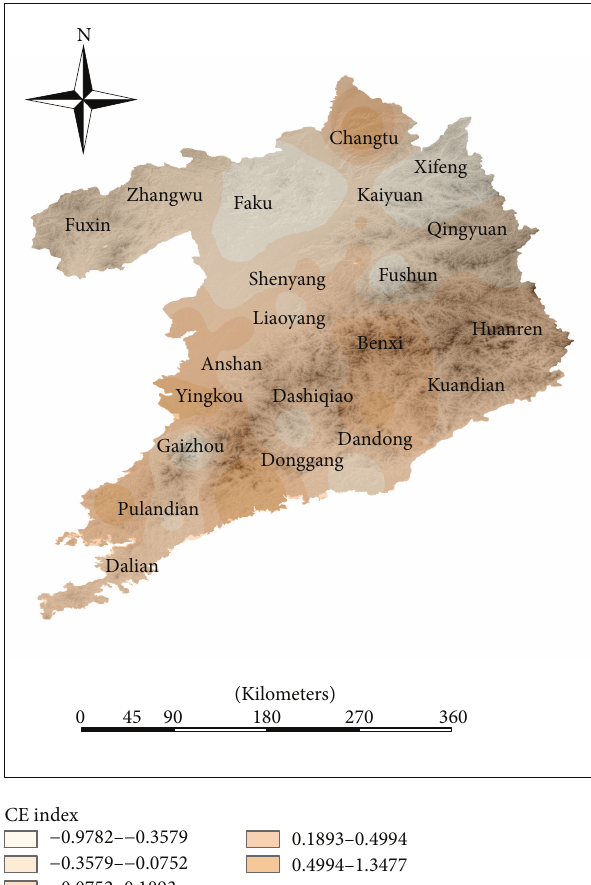
Figure 10: The distribution of climate evaluation (CE) index in Shenyang-Dalian urban agglomeration.